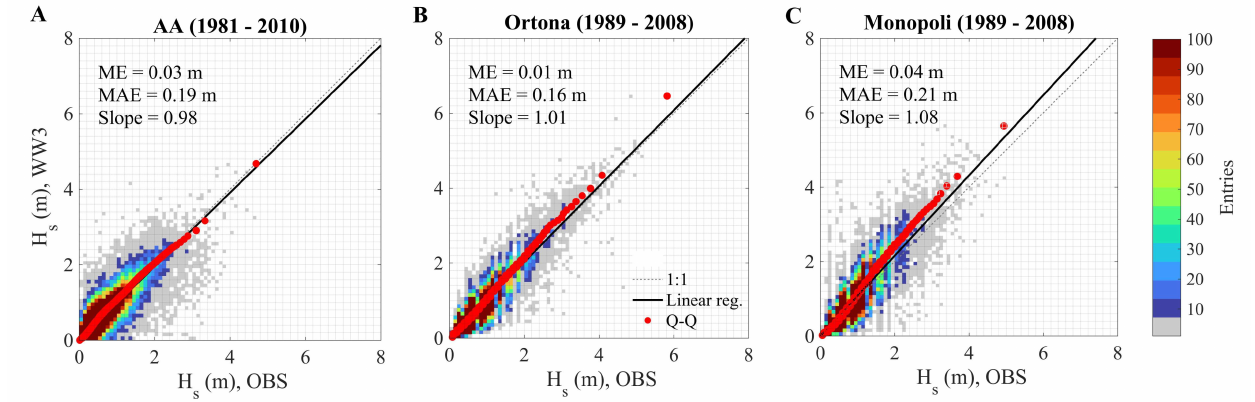
Figure 11. Performance of the WW3 model significant wave height. Comparison between model H s (in meters) against platform (Acqua Alta, total entries: 57,202; ( A )) and buoy data (Ortona, total entries: 45,346; Monopoli, total entries: 47,707; ( B , C )). Wind forging is provided by ERA5c. Scatter diagram (color shade) and quantile-quantile plot (red markers) at 1%-interval up to 99th percentile (indicated with a filled marker), and 0.1%-interval above. Mean error ( ME ), mean absolute error ( MAE ), and slope ( Slope ) of the line of best fit (solid black) are shown in the plot area. The dashed black line indicates the perfect 1:1 match between